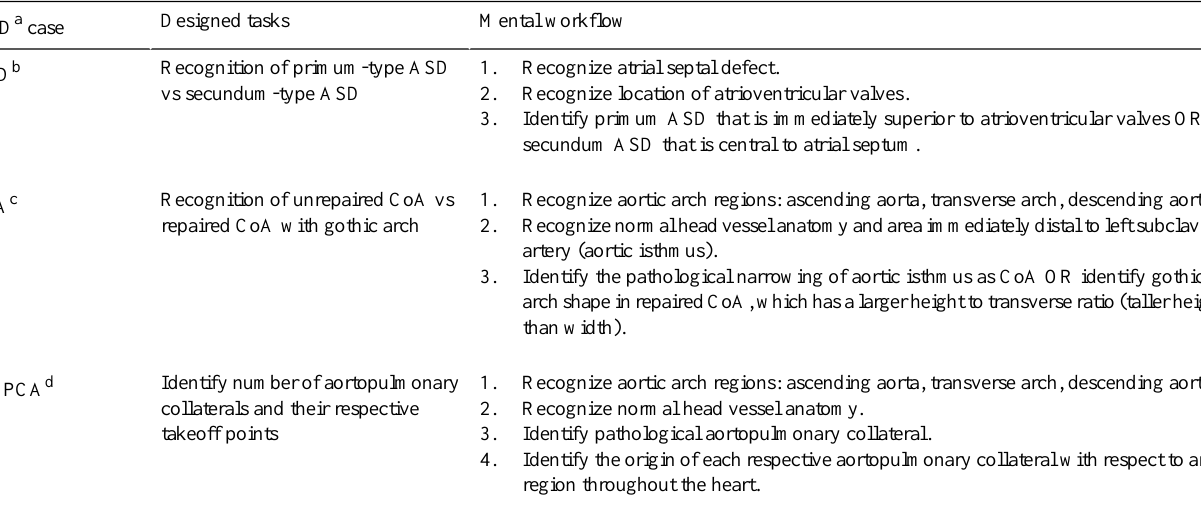
Table 1. Mental workflow for diagnosing three cases of congenital heart disease.